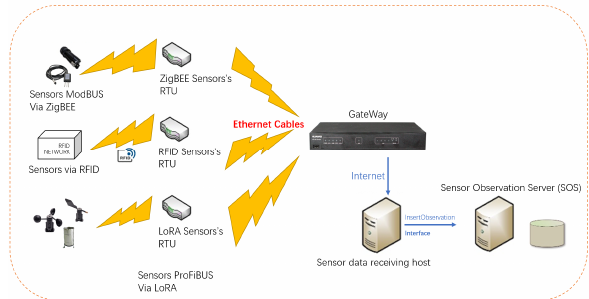
Figure 2. Sensor Web Access in the